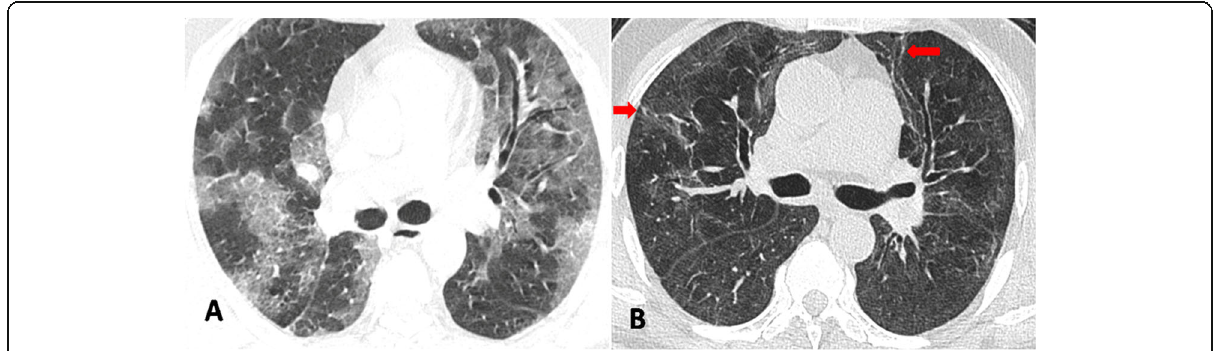
Fig. 2 Axial chest CT image in lung window settings of a 52-year-old COVID-19 patient showing diffuse ground glass opacification in both lungs just below the level of the carina at the time of hospital admission ( a ). Follow-up CT performed 97 days after the first CT reveals residual faint ground glass opacities in both lungs with architectural distortion and bronchiectasis (red arrows) ( b